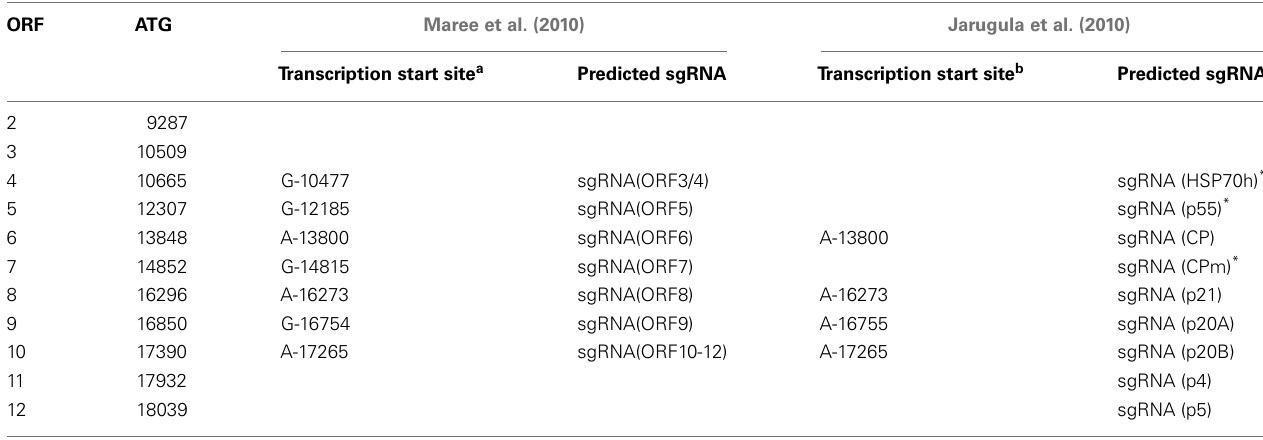
Table 3 | Position of transcription start sites of GLRaV-3